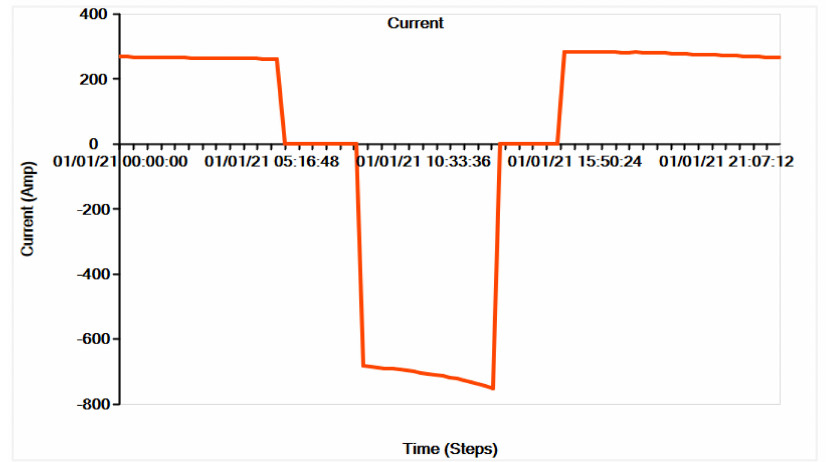
Figure 14. Lithium-ion current profile.